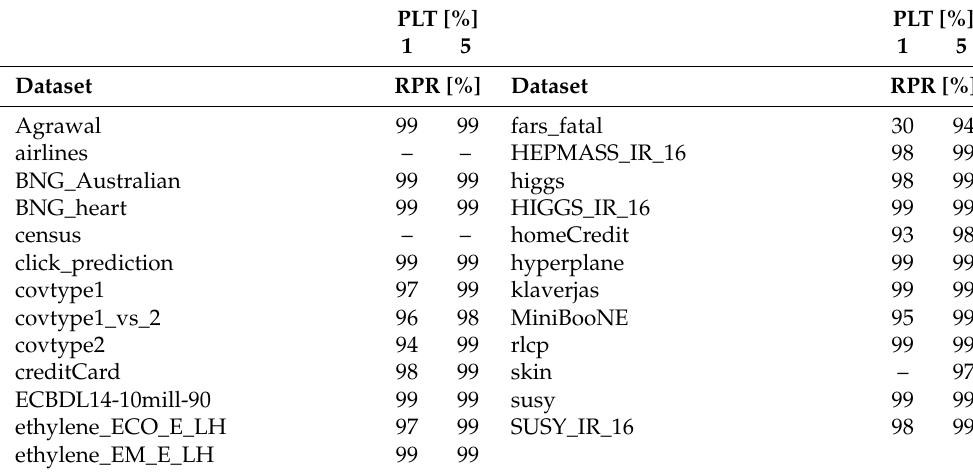
Table 5. Recommended percentage reduction (RPR) per each prediction loss threshold